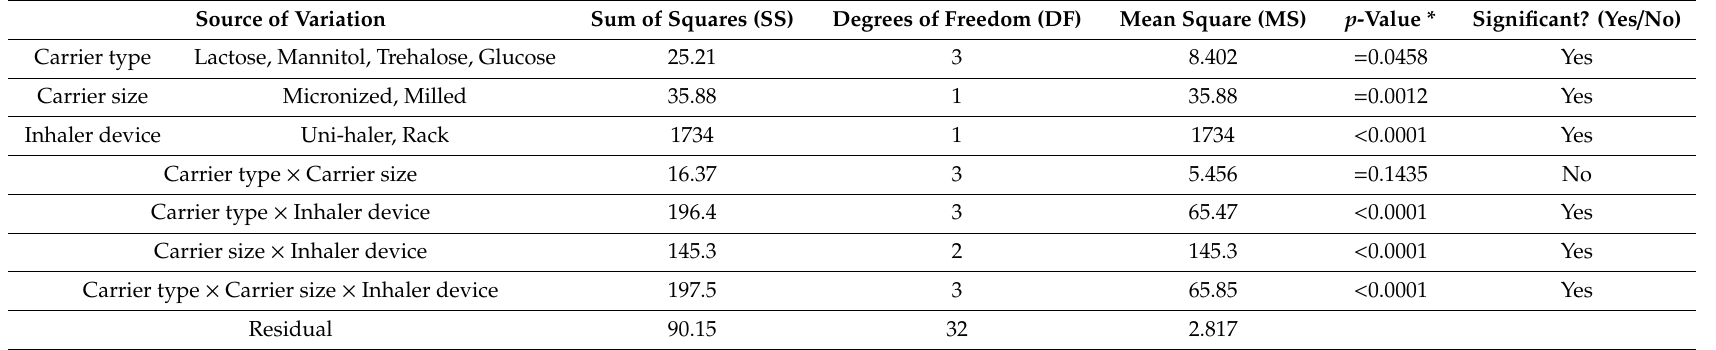
Table 3. Three-way ANOVA tabular results for each source of variation individually and